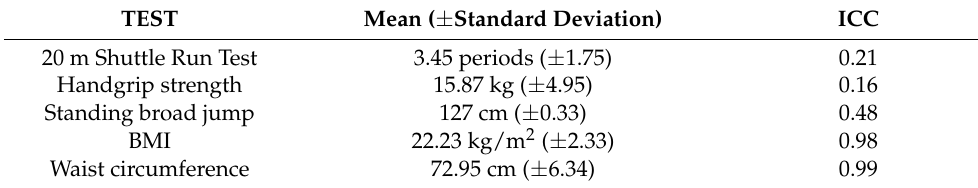
Table 2. Descriptive statistics and reliability of the ALPHA-fitness battery of